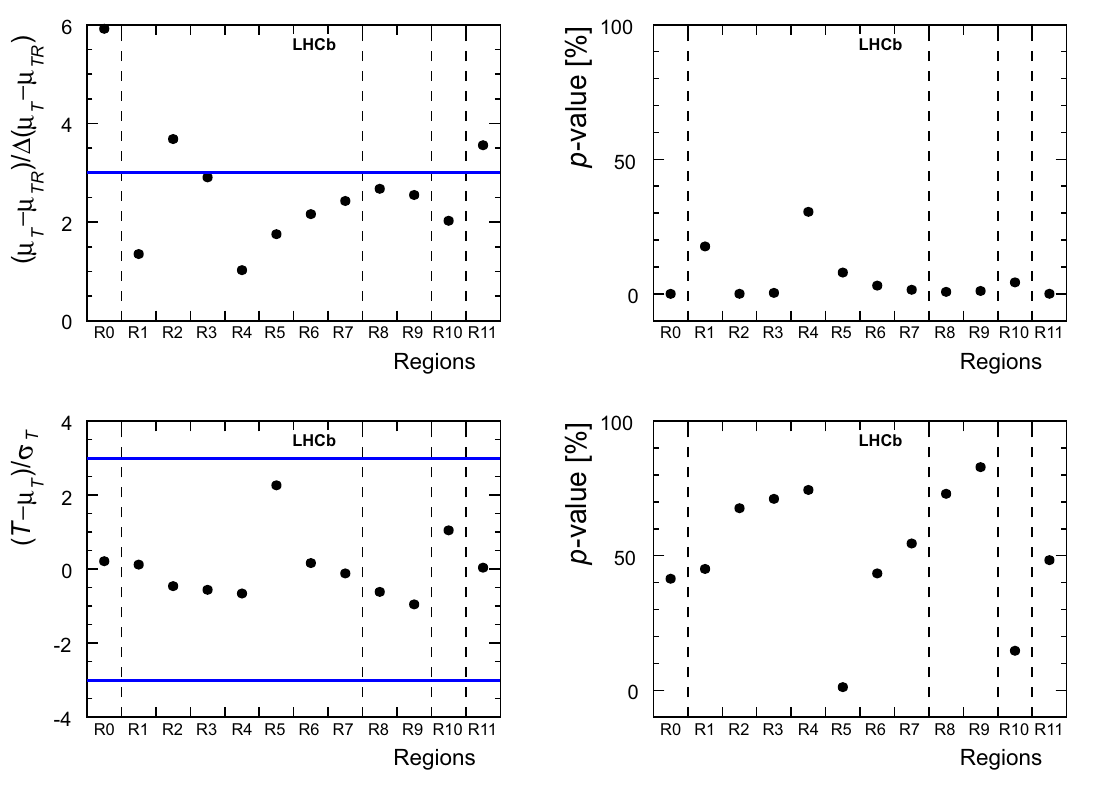
34%, consistent with the hypothesis of absence of localised